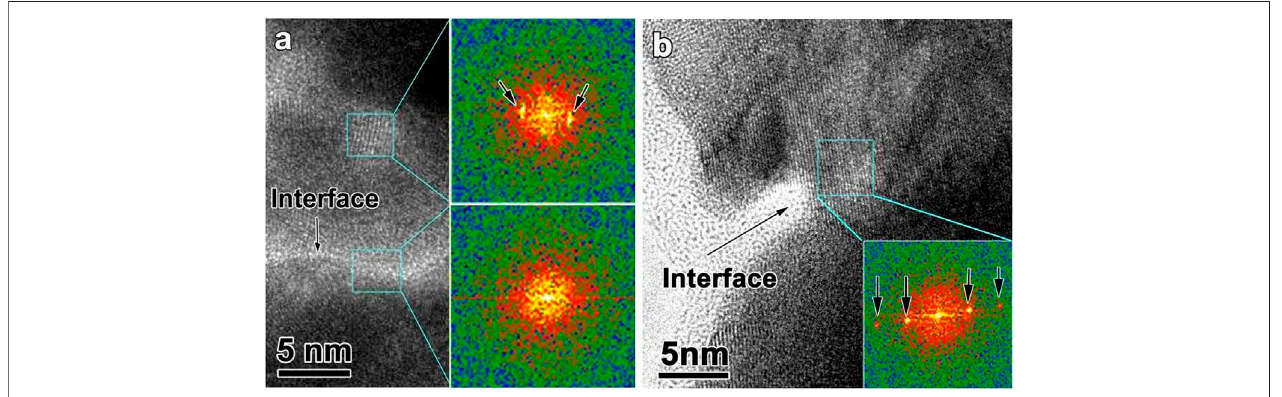
FIGURE 23 | (A) HRTEM picture near the nanoglobular interface. The results con fi rms that the interface structure remains amorphous by heating to the crystallization with300 K/s (B) HRTEM pictureneartheinterface.Theresultscon fi rmsthattheinterfacecrystalcangrowacrosstheinterfacebyheatingtocrystallization with 30,000 K/s (from (Wang J. Q. et al., 2014)).